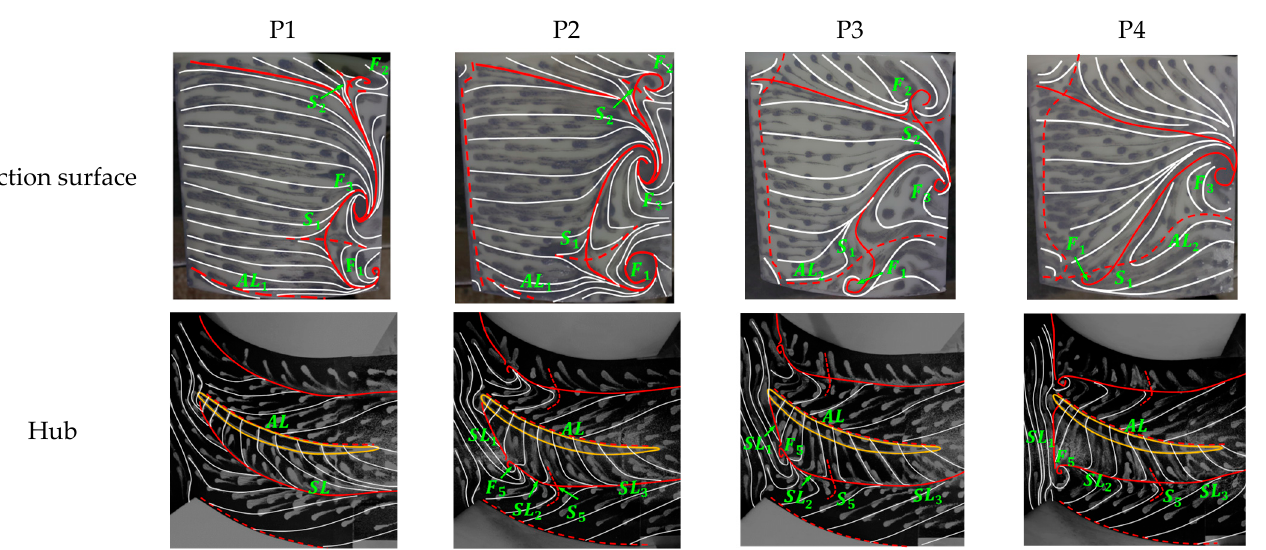
Figure 35. Oil-flow results on the blade suction surface and hub wall for the datum stator.